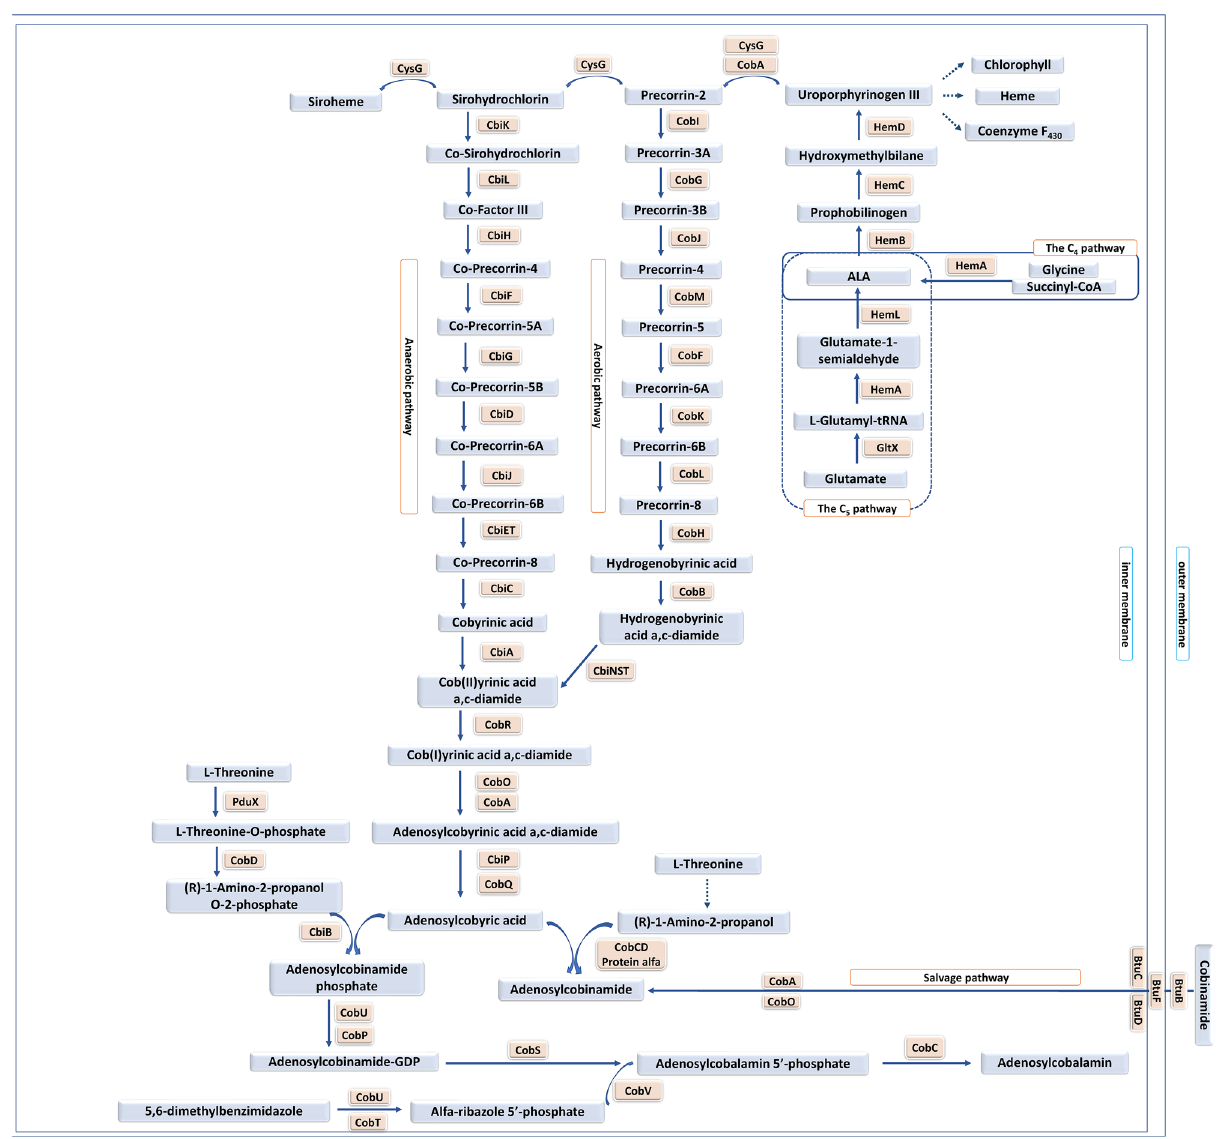
Figure 1. Synthesis of vitamin B12 in bacteria (figure adapted with permission from https:// www. ncbi. nlm. nih. gov/ pmc/ artic les/ PMC52 82855/ under the terms of the Creative Commons Attribution 4.0 International